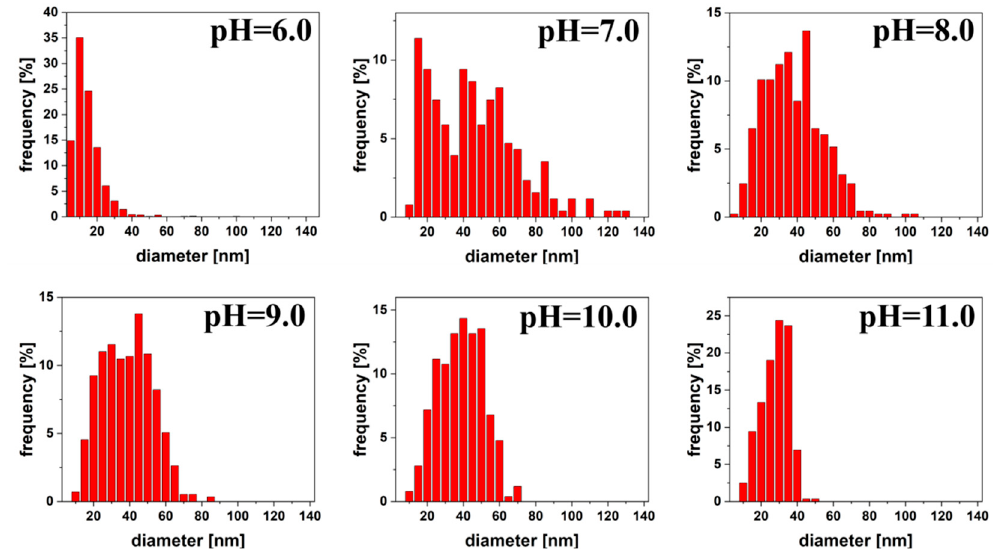
Figure 3. Size distribution of silver quasi-spherical nanoparticles reduced by citric acid at pH 6.0 to 11.0.